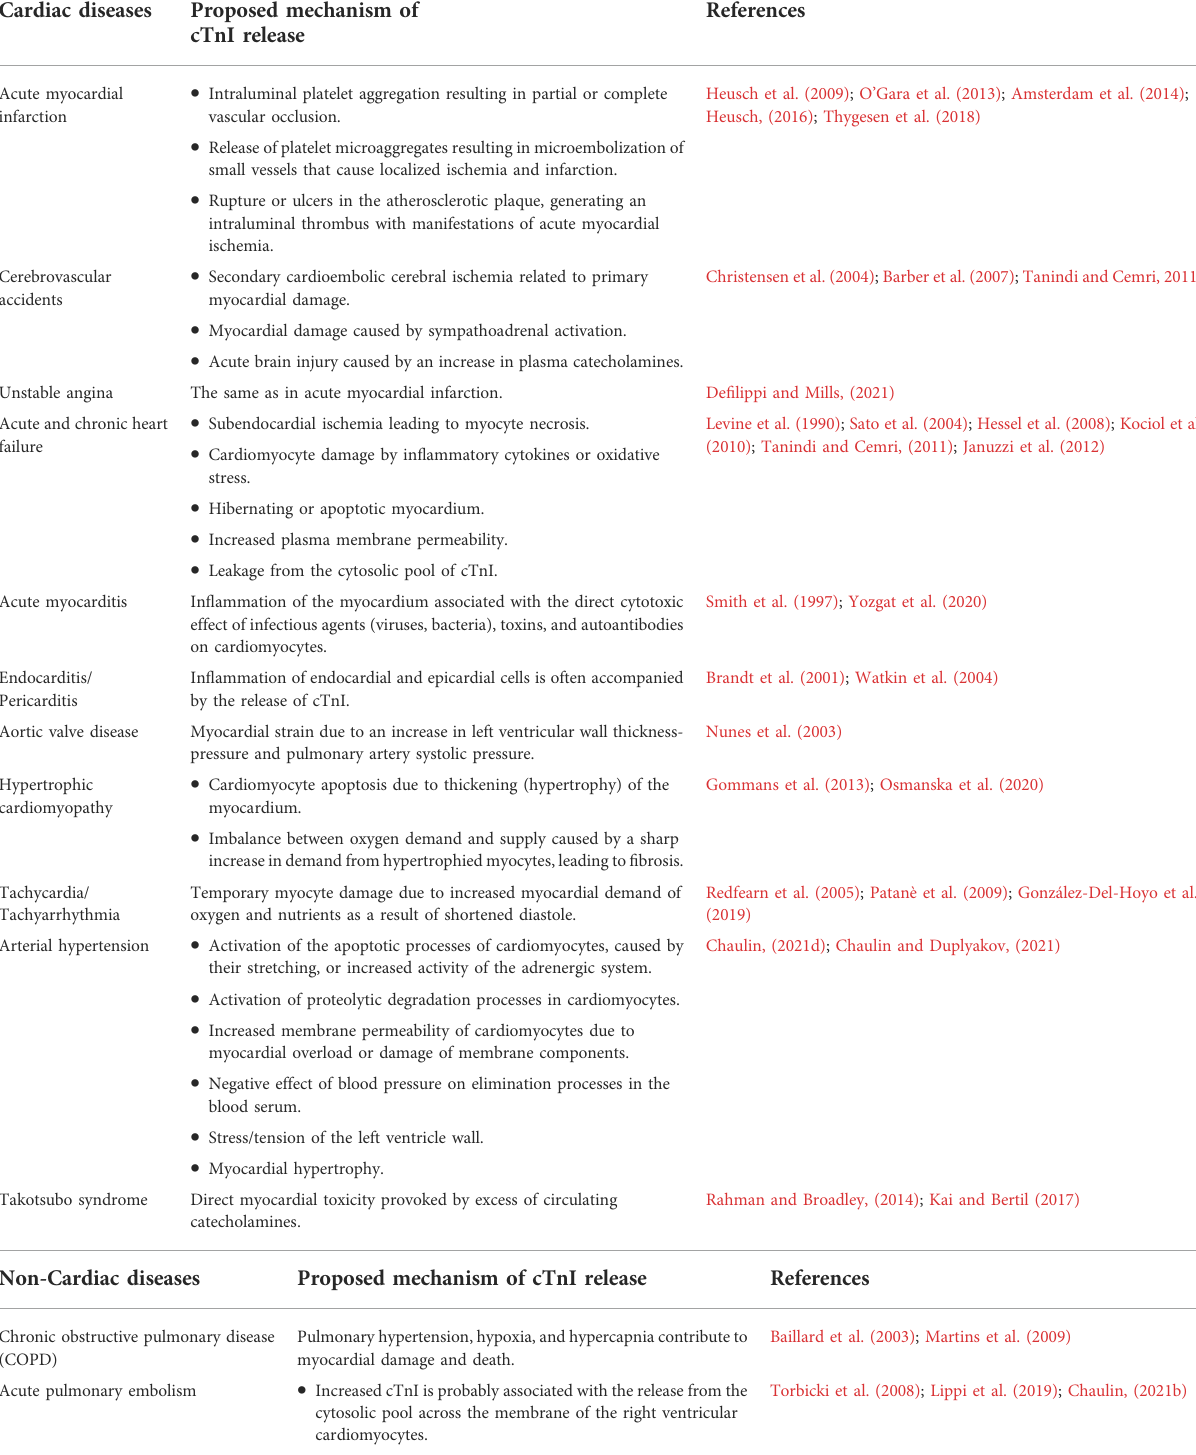
TABLE 1 Cardiac and non-cardiac diseases with cTnI release and the proposed